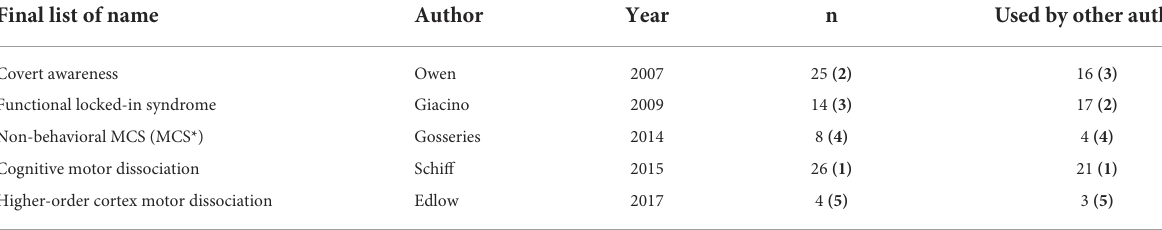
TABLE 2 Final list of names with provided definition and/or